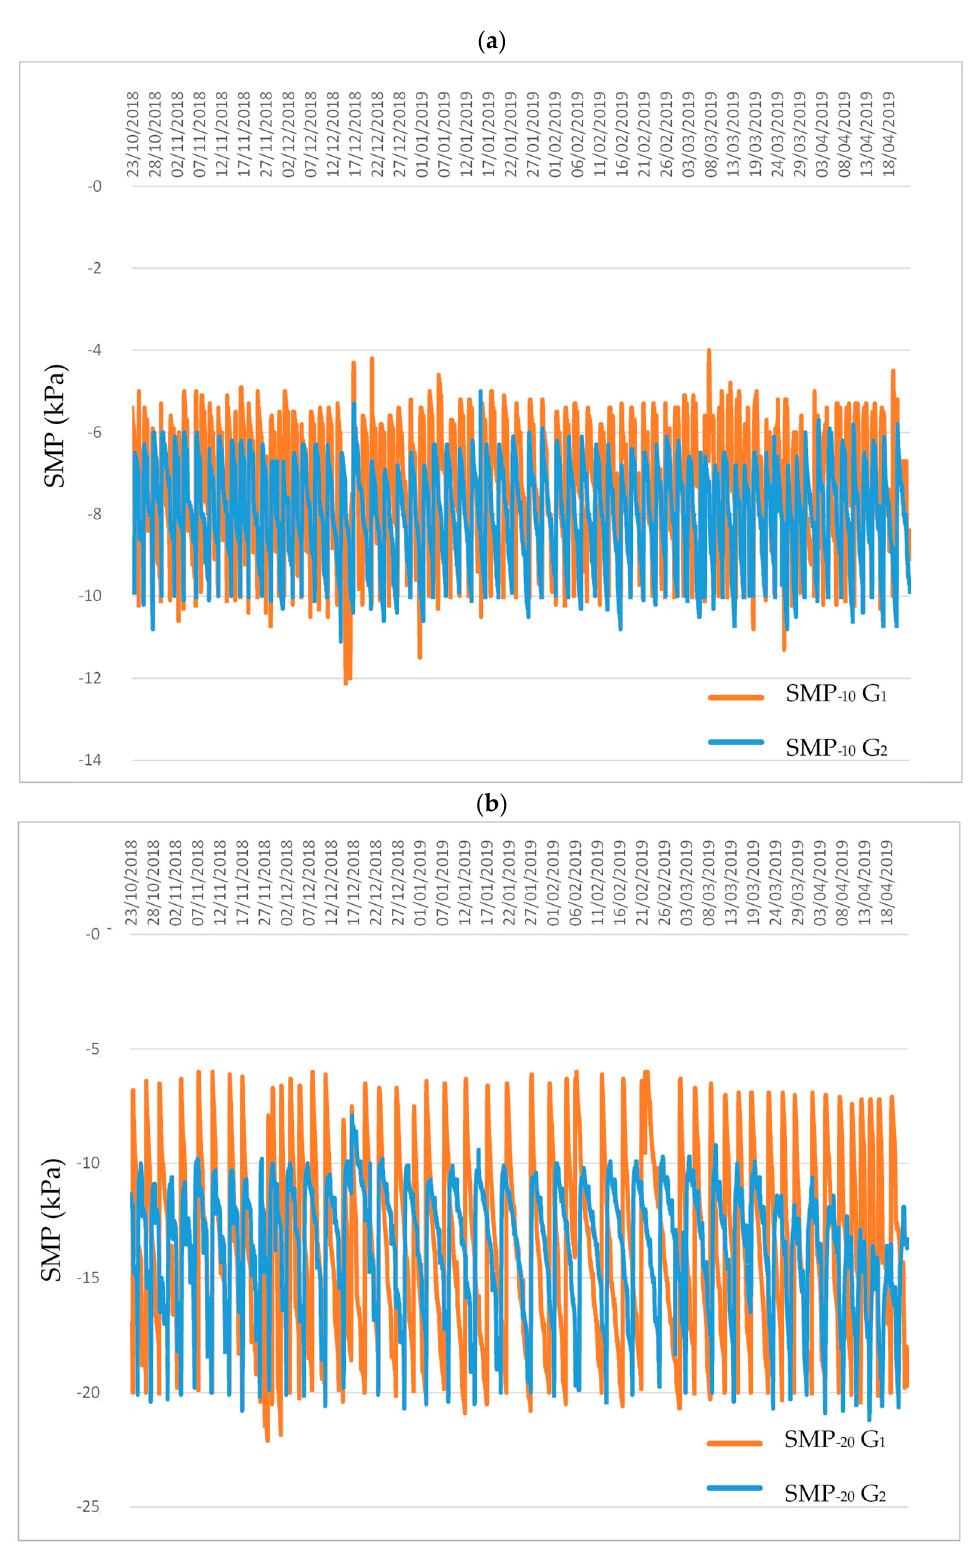
Figure 4. Soil matric potential variations for treatments in the growing seasons. Treatments SMP − 10 G 1 and SMP − 10 G 2 ( a ) represent controlling soil matric potential thresholds of − 10 kPa in the differents greenhouse studied, and treatments SMP − 20 G 1 and SMP − 20 G 2 ( b ) represent controlling soil matric potential thresholds of − 20 kPa in the differents greenhouse